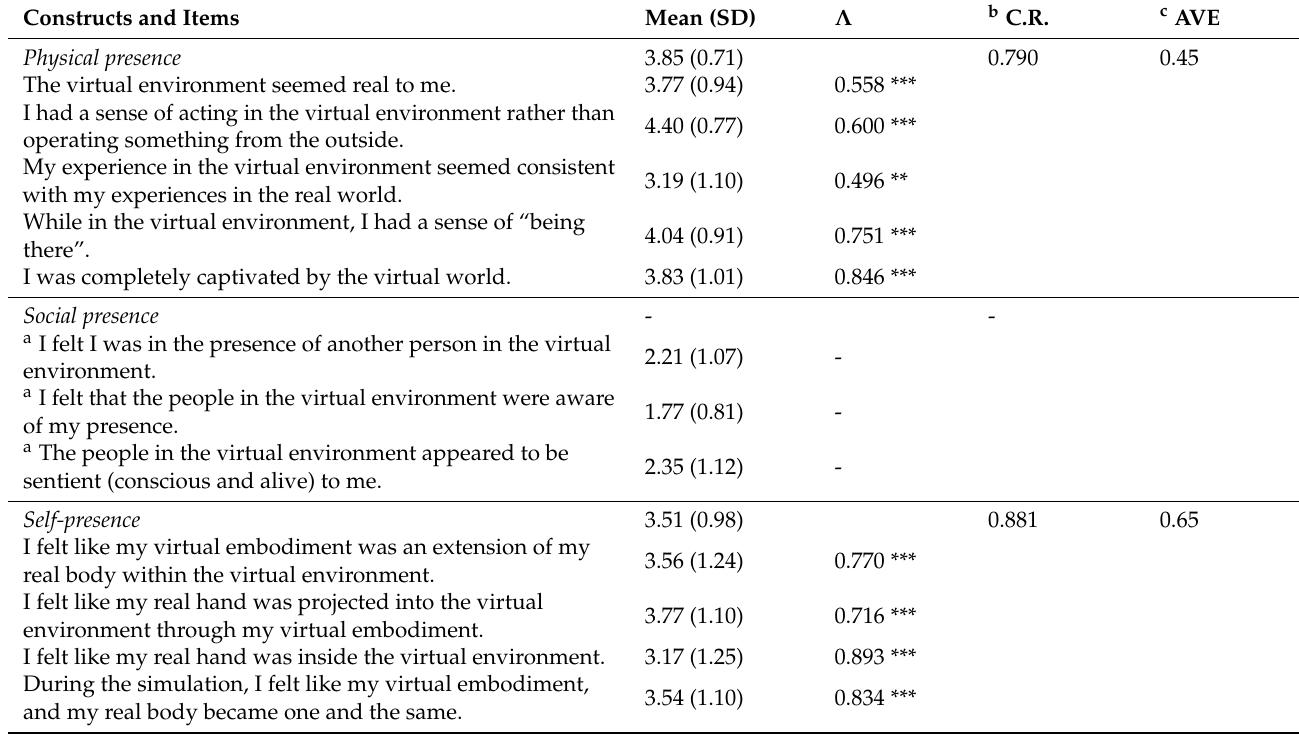
Table 3. Constructs, measurement scales, and descriptive